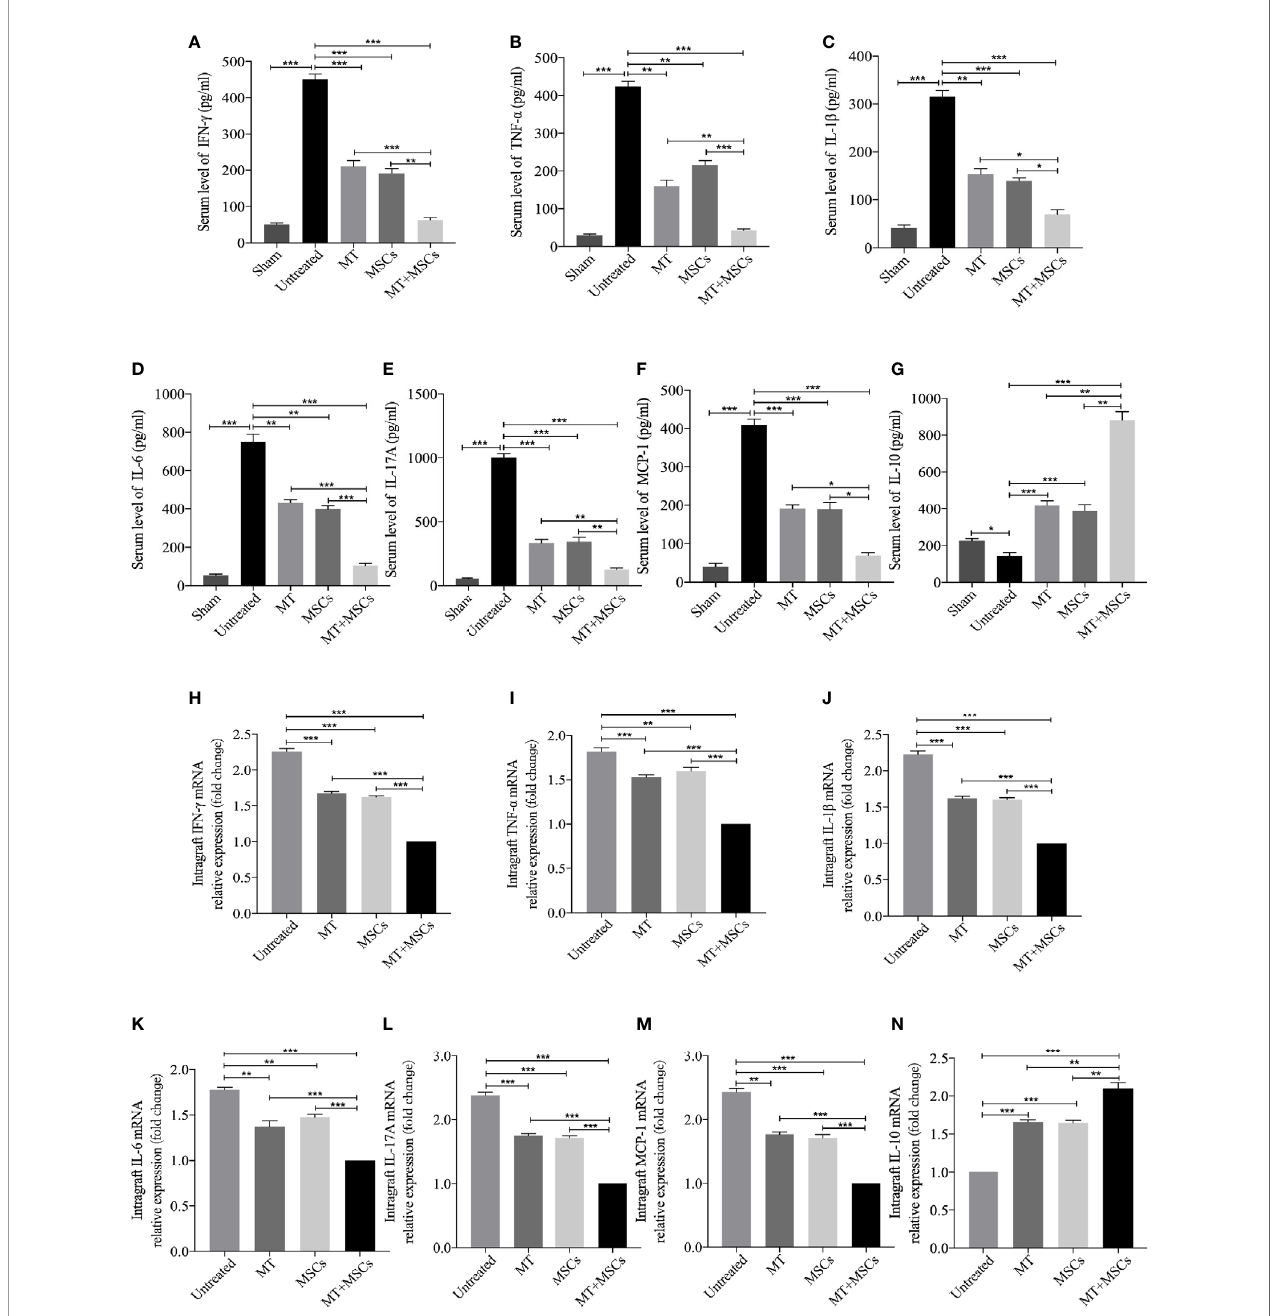
FIGURE 7 | MT in combination with MSCs further achieves reduce levels of pro-in fl ammatory cytokines, but increased level of IL-10 in transplant recipients. The IFN- g , TNF- a , IL-1 b , IL-6, IL-17A, MCP-1, and IL-10 are detected the in the recipient sera and grafts. (A) The level of serum IFN- g among the groups; (B) The level of serum TNF- a among the groups; (C) The level of serum IL-1 b among the groups; (D) The level of serum IL-6 among the groups; (E) The level of serum IL-17A among the groups; (F) The level of serum MCP-1 among the groups; (G) The level of serum IL-10 among the groups; (H) The mRNA expression levels of IFN- g among the groups; (I) The mRNA expression level of TNF- a among the groups; (J) The mRNA expression level of IL-1 b among the groups; (K) The mRNA expression level of IL-6 among the groups; (L) The mRNA expression level of IL-17A among the groups; (M) The mRNA expression level of MCP-1 among the groups; (N) The mRNA expression level of IL-10 among the groups. Statistical analysis is performed by one-way analysis of variance (ANOVA), n = 10 per group, * p <.05, ** p <.01, and *** p <.001. Bar graphs represent mean ± SEM. MT, melatonin; MSCs, mesenchymal stromal cells. The experiments were independently repeated three